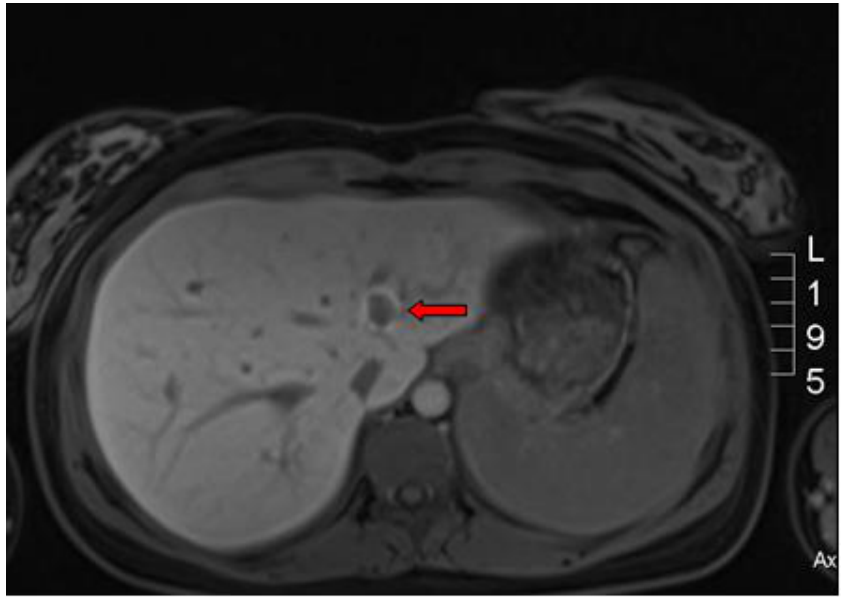
Figure 2: T1 weighted MRI (axial view): Liver lesion consistent with focal nodular hyperplasia